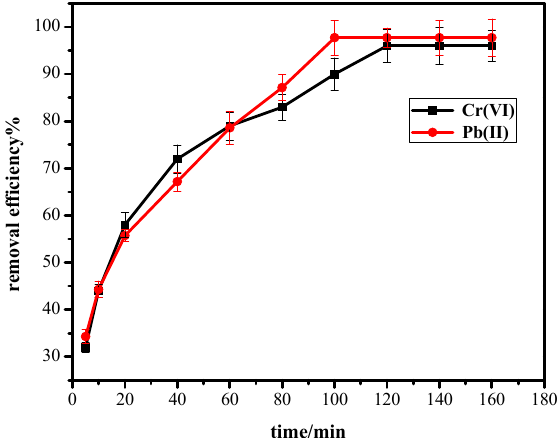
Figure 4. Effect of time on removal efficiency of Pb(II) and Cr(VI) ions on AAJPL (adsorbent